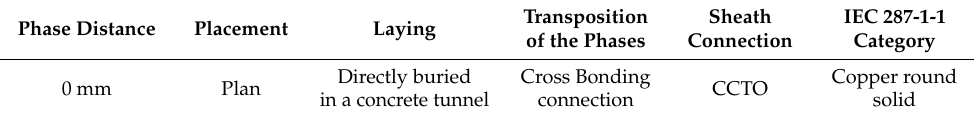
Table 3. Operating characteristics of the